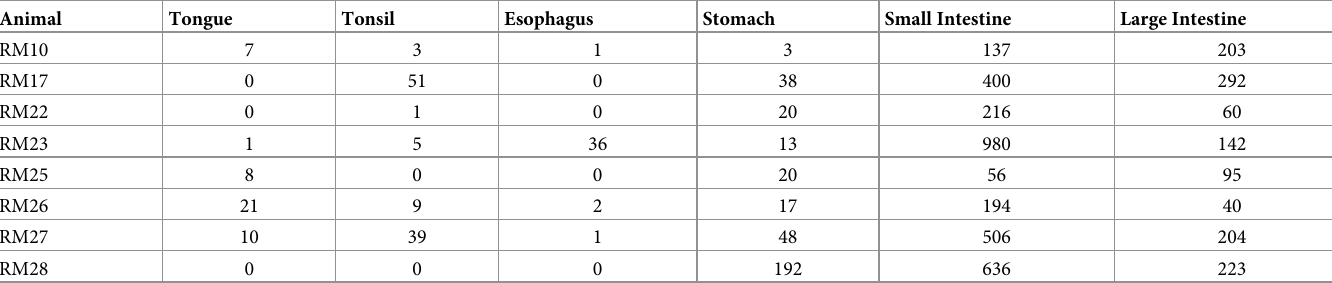
Number of SHIV-1157ipd3N4 infected cells found throughout the oral mucosa and GI tract after oral